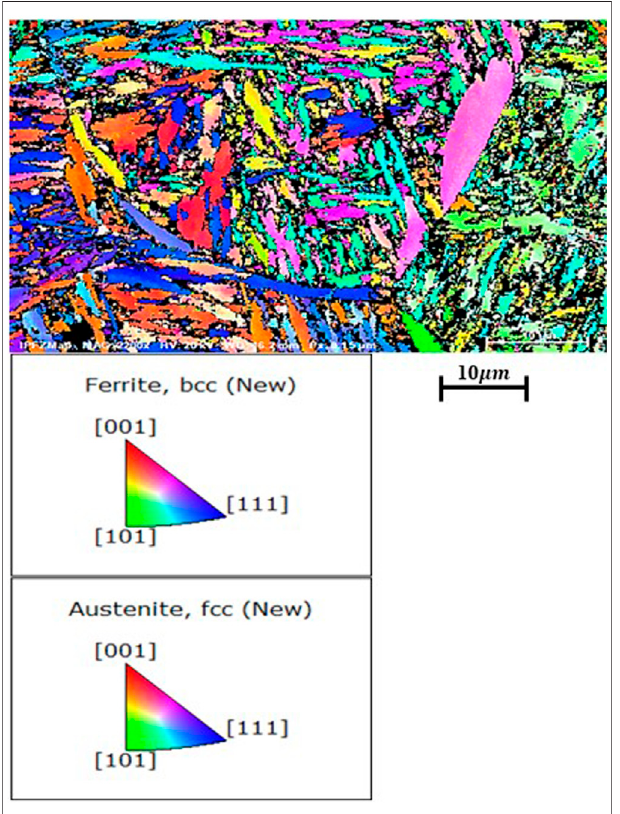
FIGURE 13 | Electron backscatter diffraction EBSD) measurement of specimen deformed at 1,250 ° C 0.01 s − 1 .